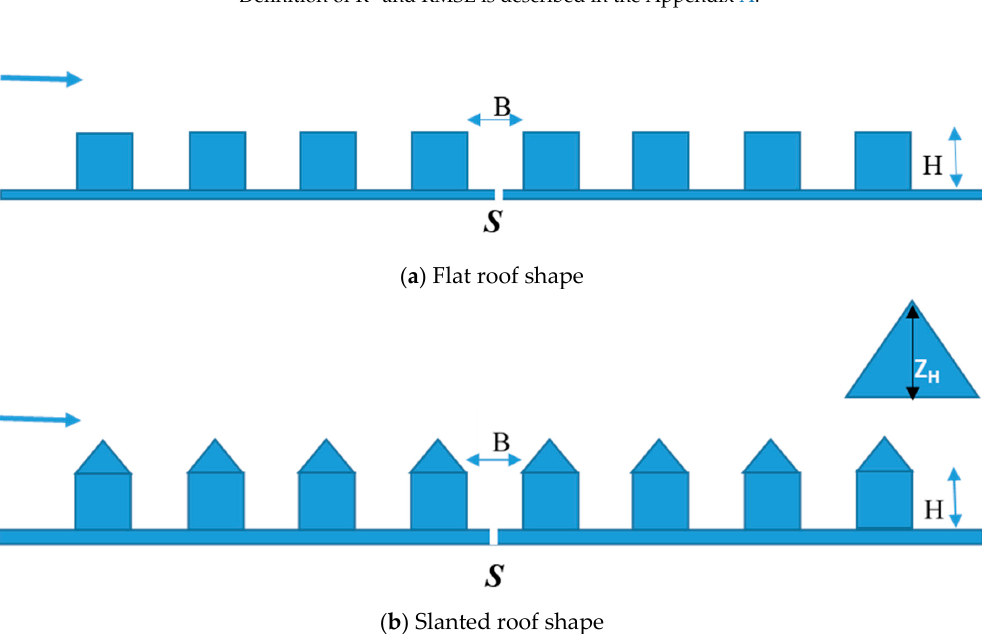
Figure 16. Experimental set-up by Rafailidis and Schatzmann [42]. ( a ) Flat roof shape, ( b ) Slanted roof shape.